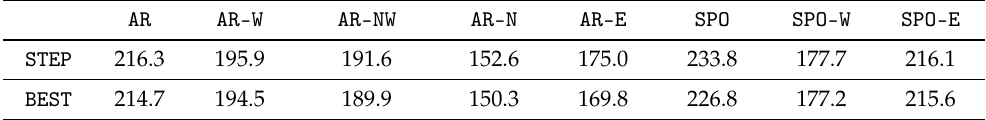
Table 2. The AICc values for the models STEP and BEST in each